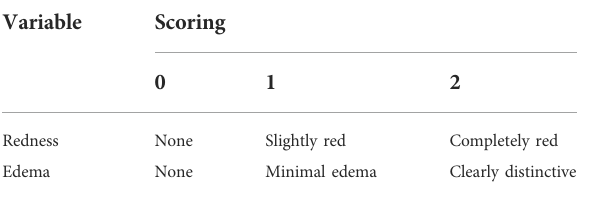
TABLE1Macroscopicscoringsystemusedforburns.Source:Schlager et al.